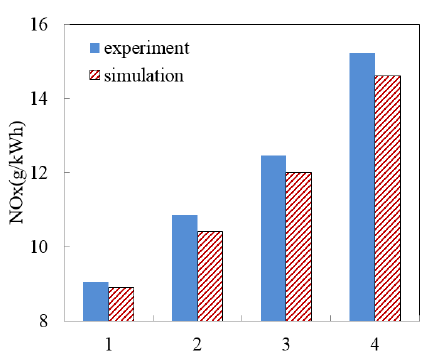
Figure 7. NO x emissions of E3 test cycle condition compared with simulation